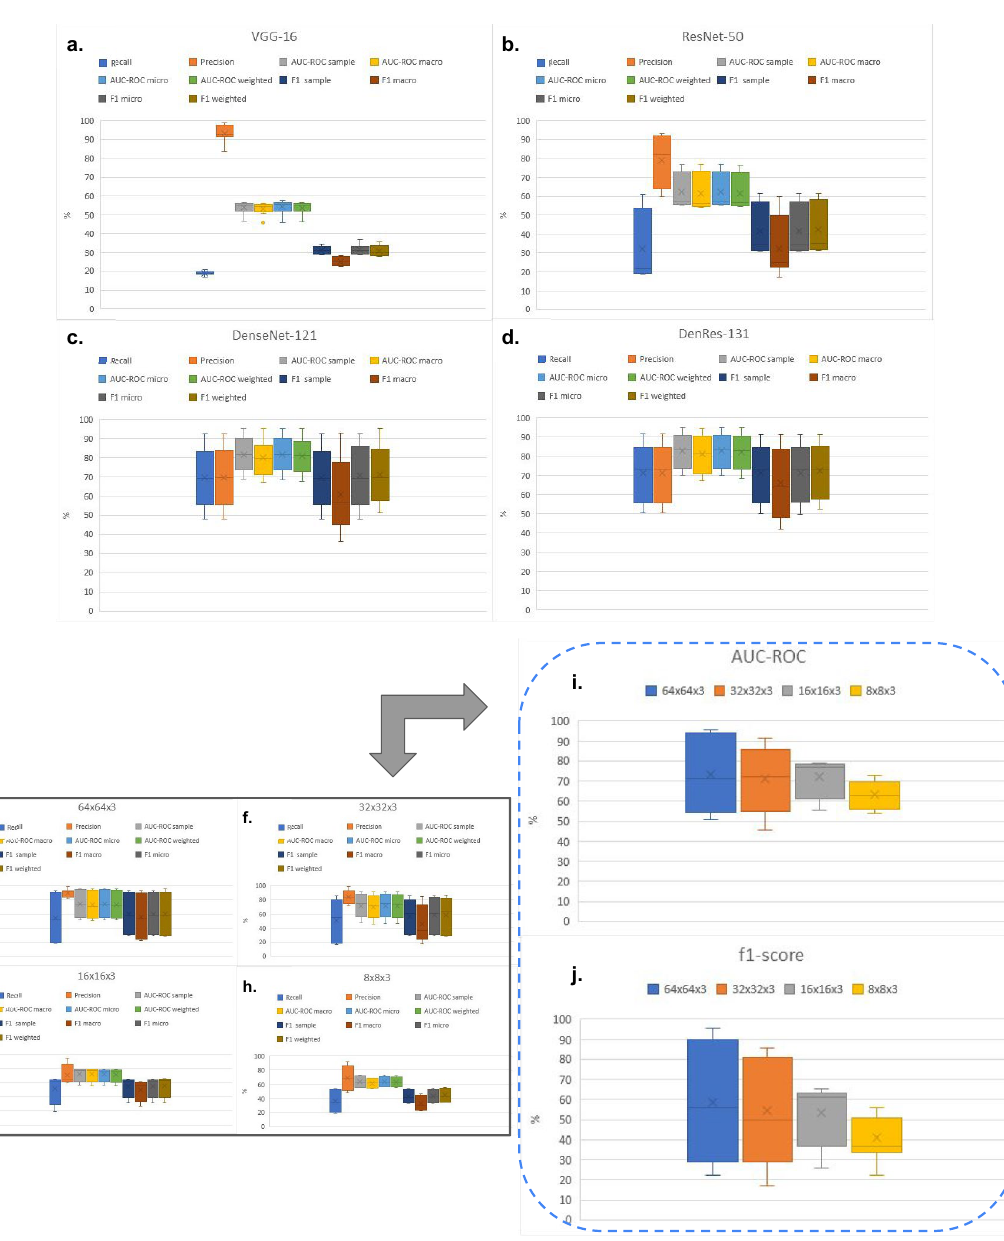
Figure 2. Box and Whisker plots results of Vgg-16, ResNet-50, DenseNet-121, and DenRes-131 for the multi-classification task. ( a – d ) Box-plots results for the different deep learning networks (Vgg-16, ResNet- 50,DenseNet-121, and DenRes-131, respectively) for the combine results of all the different size of 3D patch sizes. The results presented are a variation of metrics (Recall, Precision, AUC-ROC, and f1-score) scores. ( e – h ) Box-plots results for the different patch sizes ( 64 × 64 × 3 , 32 × 32 × 3 , 16 × 16 × 3 , and 8 × 8 × 3 height, width and depth respectively) of all the deep learning networks combine results. ( e – h ) are presented the results of a variation of metrics (Recall, Precision, AUC-ROC, and f1-score). ( i , j ) Summarizing the f1-score and AUC- ROC metrics